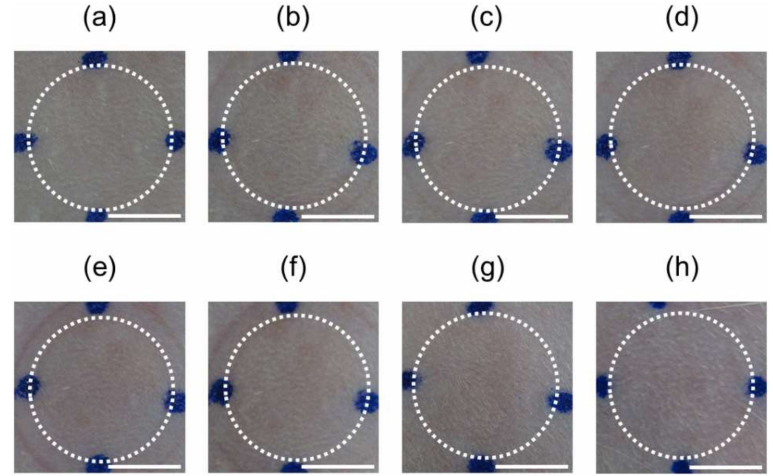
Figure 7. Skin irritation observed following application of human parathyroid hormone (1-34) (PTH)-loaded microneedle arrays (MNs). Typical images of rat skin ( a ) before application of PTH-loaded MNs, ( b ) immediately after removal, and ( c ) 1 h, ( d ) 2 h, ( e ) 3 h, ( f ) 4 h, ( g ) 24 h, and ( h ) 48 h after application of PTH-loaded MNs. Scale bars represent 5 mm.